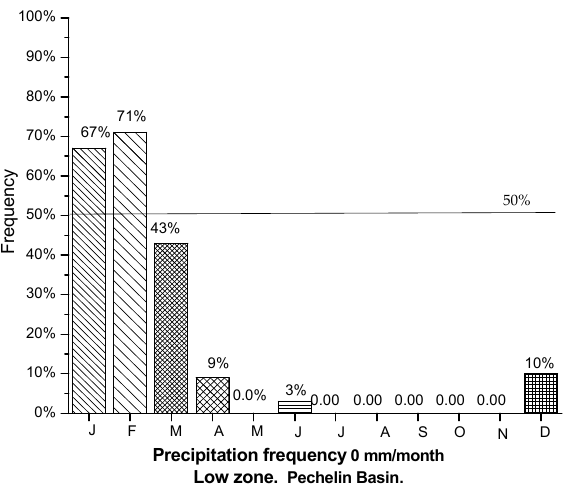
Figure 10. Precipitation frequency 0 mm/month in the low zone, Pechelín basin.